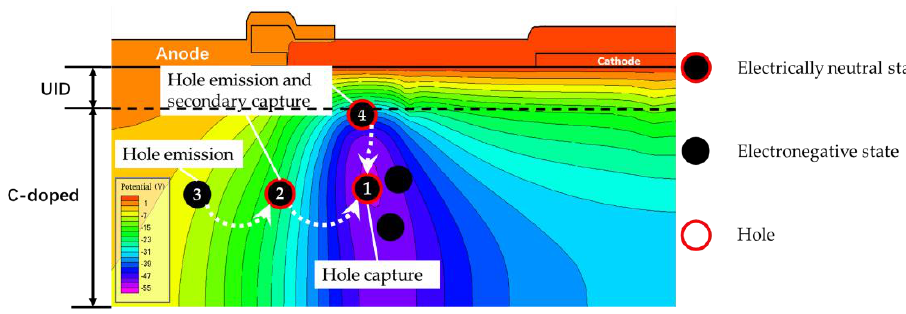
Figure 9. Schematic diagram of secondary capture process.